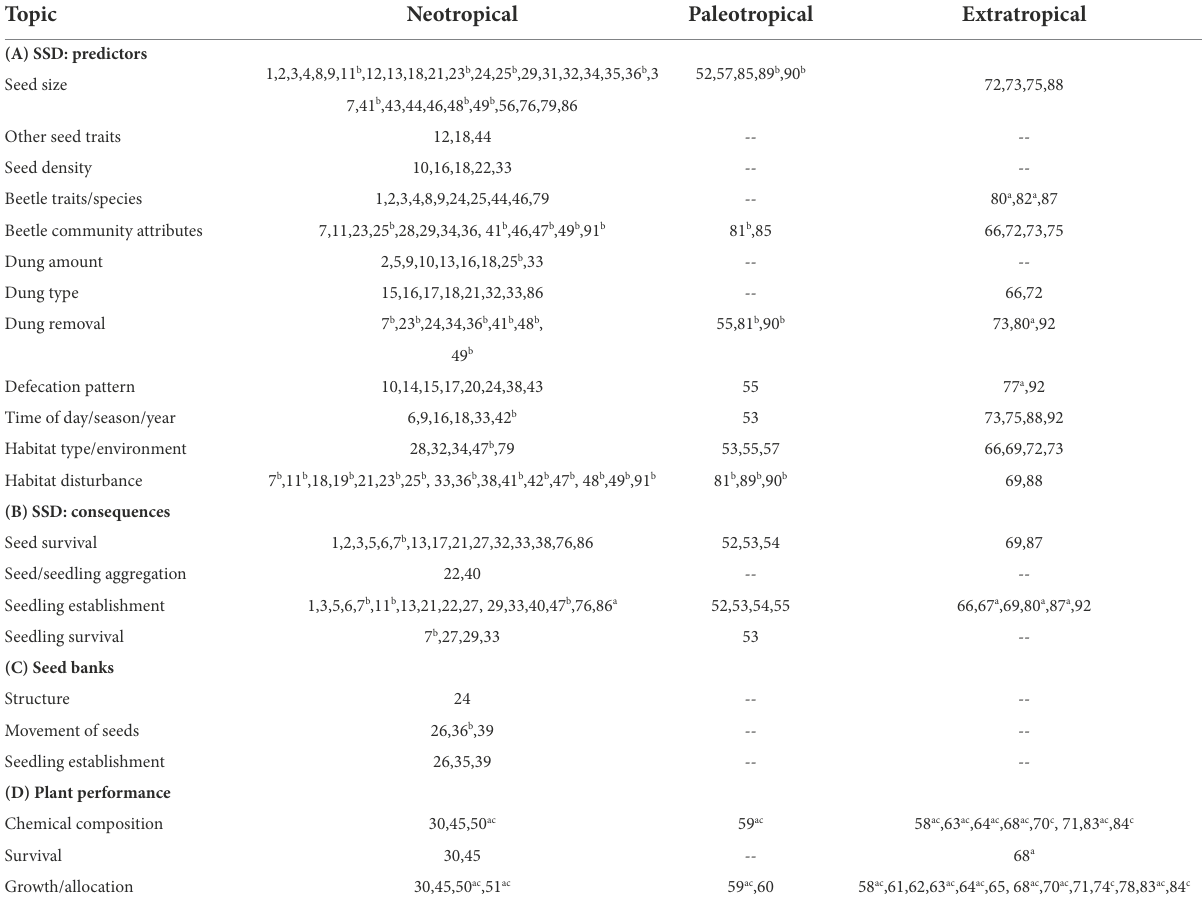
TABLE 1 List of publications (excluding reviews) that include information on the effects of dung beetle activity on plants in three realms: Neotropical, Paleotropical, and Extratropical. Topic